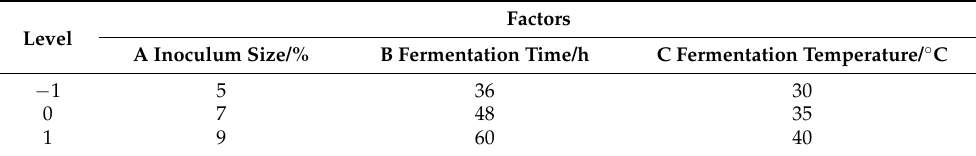
Table 1. Response surface test factors and